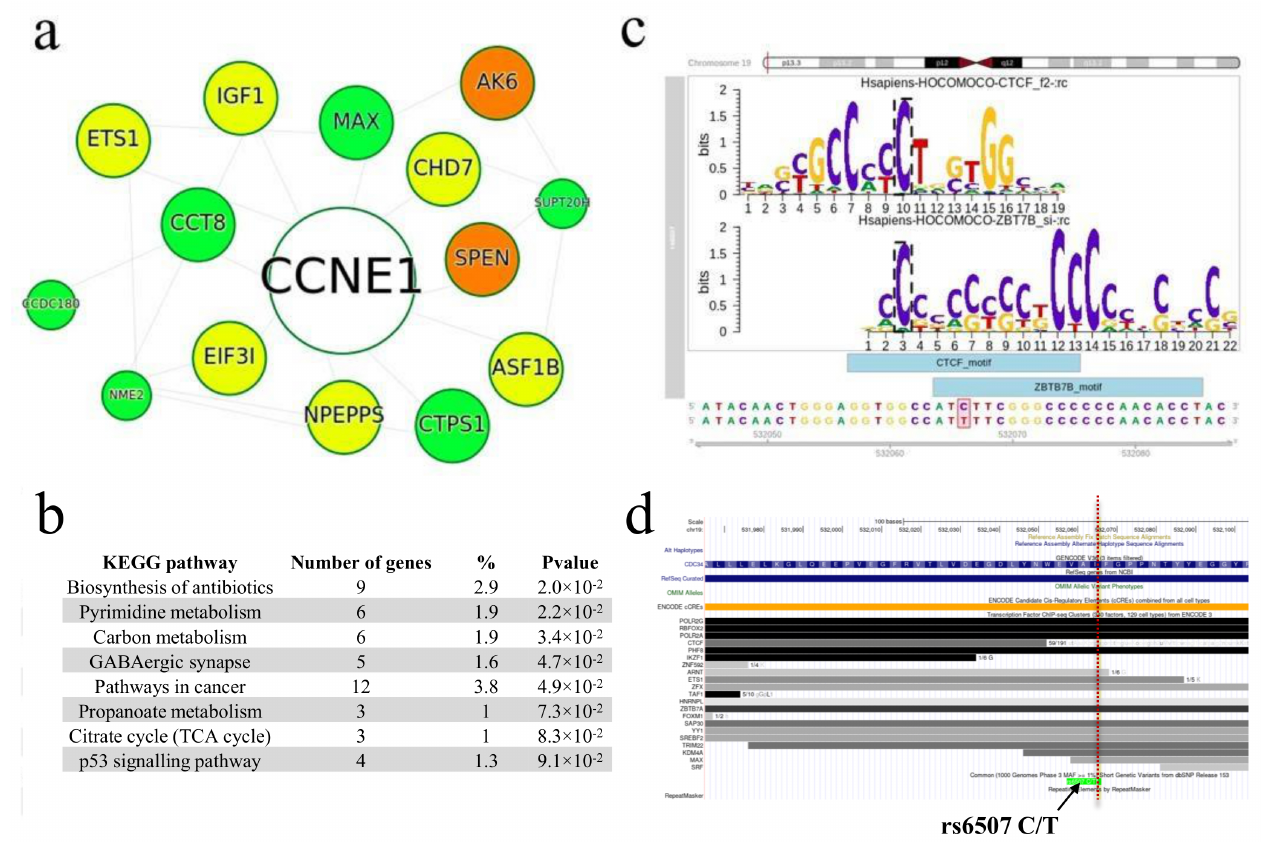
Figure 6. rs6507 (C>T) findings. ( a ) PPI subnetwork for rs6507 with the ‘root’ CCNE1 protein using R STRINGdb. Nodes are colored according to logFC value (green nodes: logFC < − 0.5; orange nodes: logFC > 0.5; yellow nodes: |logFC| < 0.5) and node sizes are proportional to |logFC|. ( b ) The enriched KEGG functional terms for 337 corresponding DEGs are ranked according to the adjusted p -value and displayed in a tabular format. ( c ) Disruption of CTCF and ZBTB7B binding motifs by rs6507 (C>T). The red bar shows the chromosome location of rs6507. ( d ) The genome region surrounding rs6507 with visualized ChIP-Seq signal tracks for CTCF as given by ENCODE annotation (ICGC Genome browser). The location of rs6507 is highlighted with the red dotted